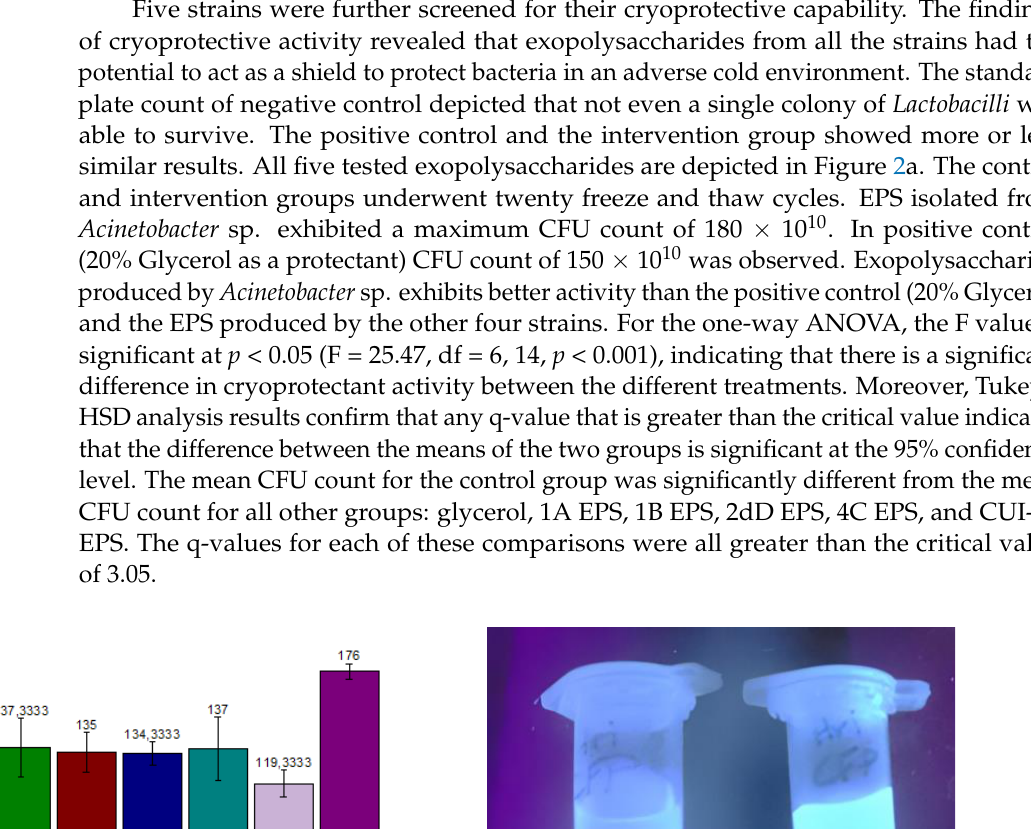
Table 2. Emulsifying activity of CUI-P1 exopolysaccharide (EPS). Emulsifier